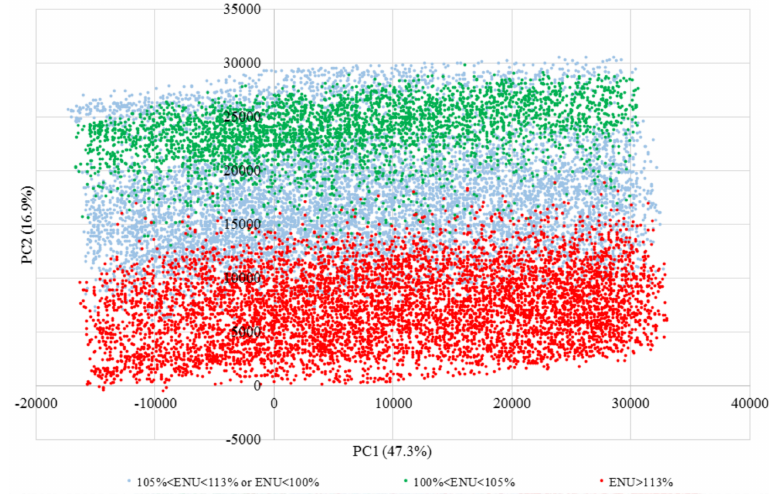
Figure 5. Bi-plot of ENU values in the non-leaky